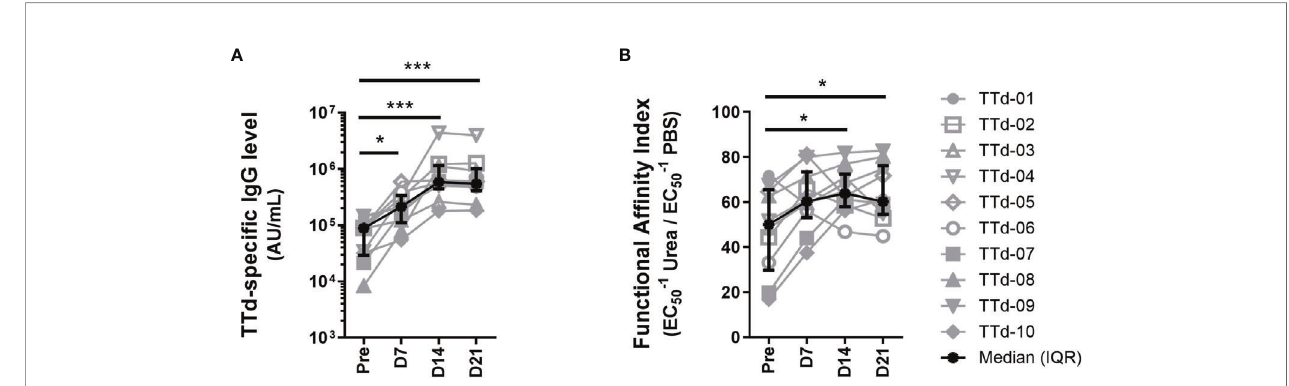
FIGURE 1 | Plasma TTd-speci fi c IgG antibody levels and functional af fi nity index before and after booster ADT vaccination in healthy adults. (A) Plasma TTd-speci fi c IgG antibody levels were measured, in duplicate, using an in-house TTd-speci fi c IgG ELISA. (B) The same ELISA was modi fi ed to include a chaotropic elution